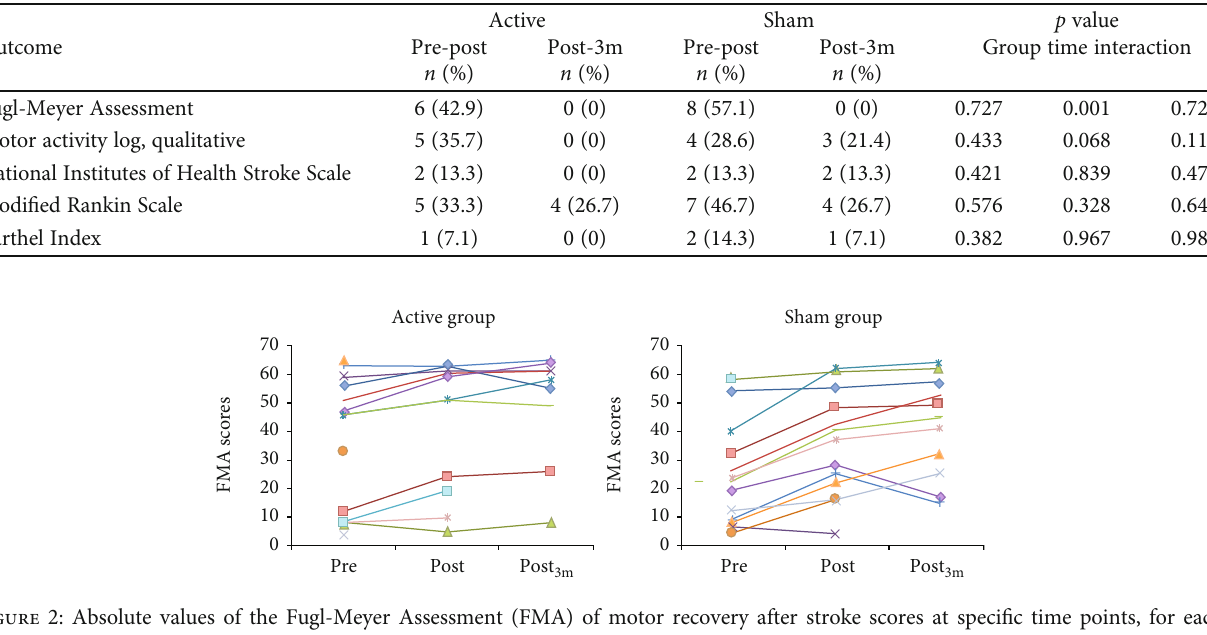
Table 3: Minimal clinically important di ff erences for secondary outcomes. Intention-to-treat analysis, Generalized Estimating Equations model with binomial distribution.